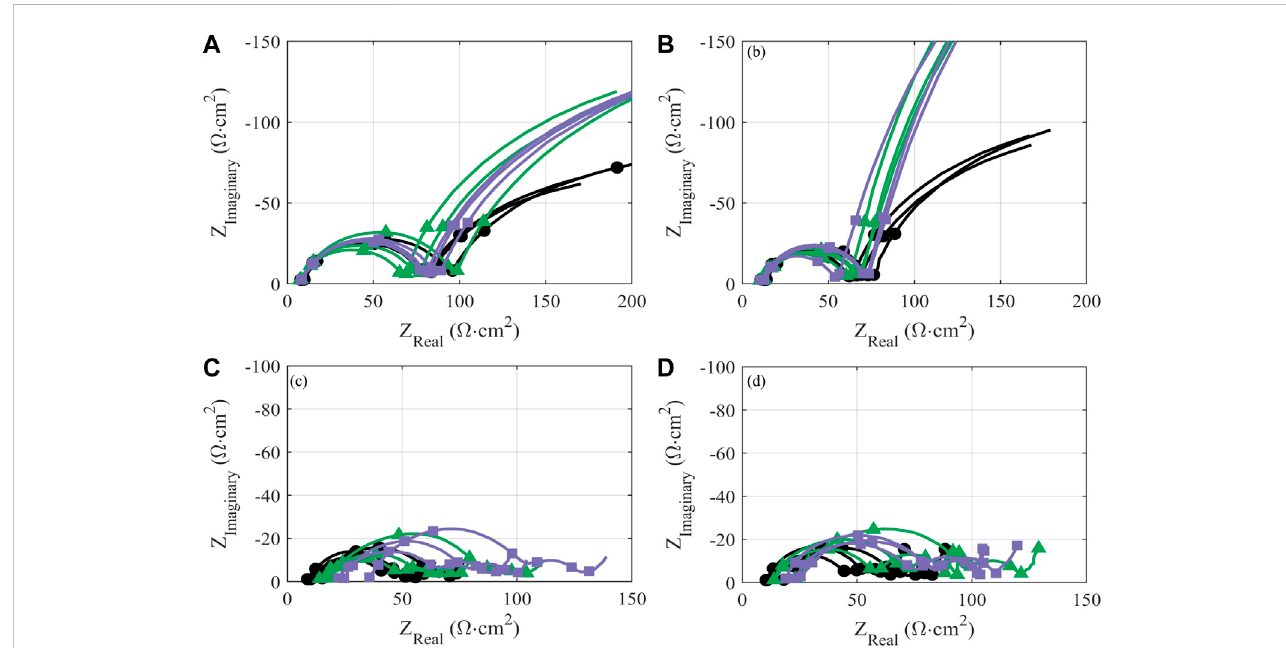
FIGURE 6 Area-normalized impedance of half cells (A,B) and full cells (C,D) prepared with NMC-111: pristine (black circles) or following treatment in KOH (green triangles)or KOH+ KCl(purplesquares)matrix.Measurementsare reported after formation cycles (A,C) and after 25cycles atC/10 following formation (B,D) . AlltreatedNMCsamplesweresubjecttothesameprocessing conditions(i.e.,sonicationat60 ° Cfor 2.5 h).Themarkersontheimpedancegraphsarelocated on the frequency decades, starting at 10 5 Hz on the lower left-hand side of the axis and at every frequency decade until the end of the